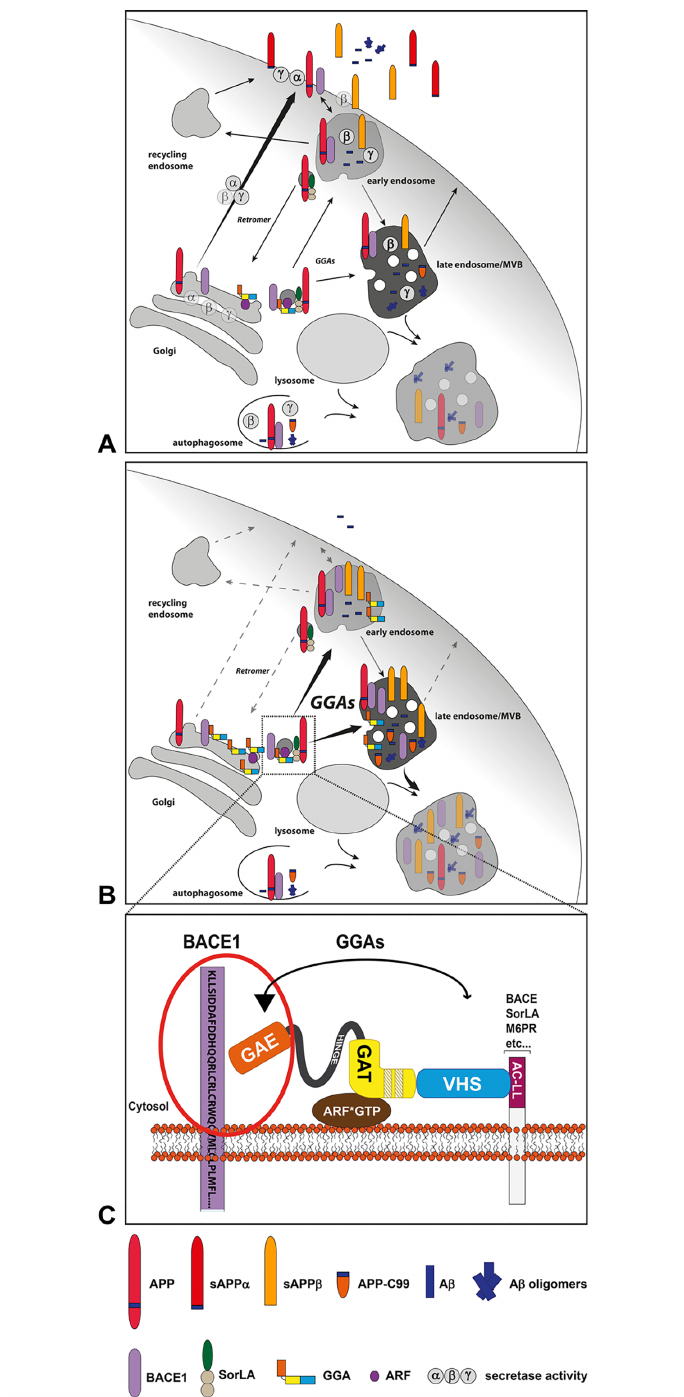
Fig 6. GGA-dependent BACE1 sorting and APP processing. (A) APP and BACE1 are transported to the cell surface via secretory pathways. Both can be internalized into endosomal compartments where acidic conditions promote APP cleavage by BACE1 and A β generation. APP cleavage products and BACE1 are either recycled to the cell surface or sorted into late endosomal/lysosomal parthway for degradation. Likewise, APP, C99 and β - and γ -secretase can be sorted into autophagosomes for degradation as reviewed [61]. Increased secretase activity in these compartments were described to enhance A β production and the acidic conditions also promote A β aggregation [62 – 64]. Therefore, disturbed lysosomal degradation leads